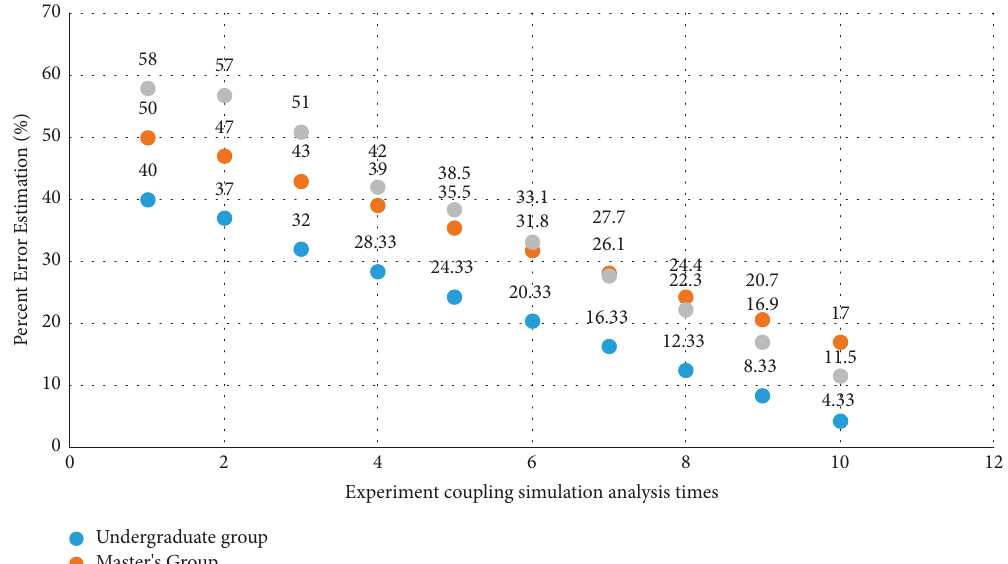
Figure 4: The percentage error obtained under the number of experiments with different degrees of coupling under deep learning.